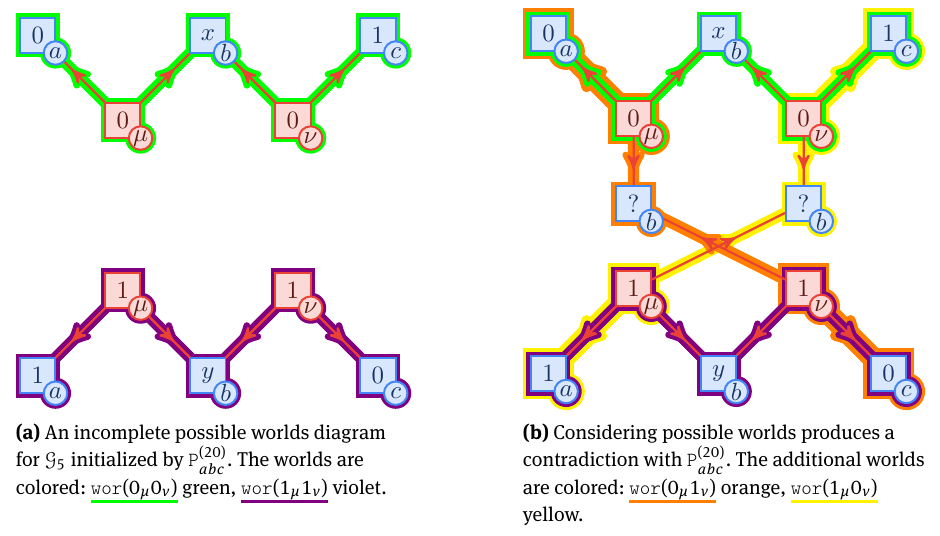
(Equation 20). abc